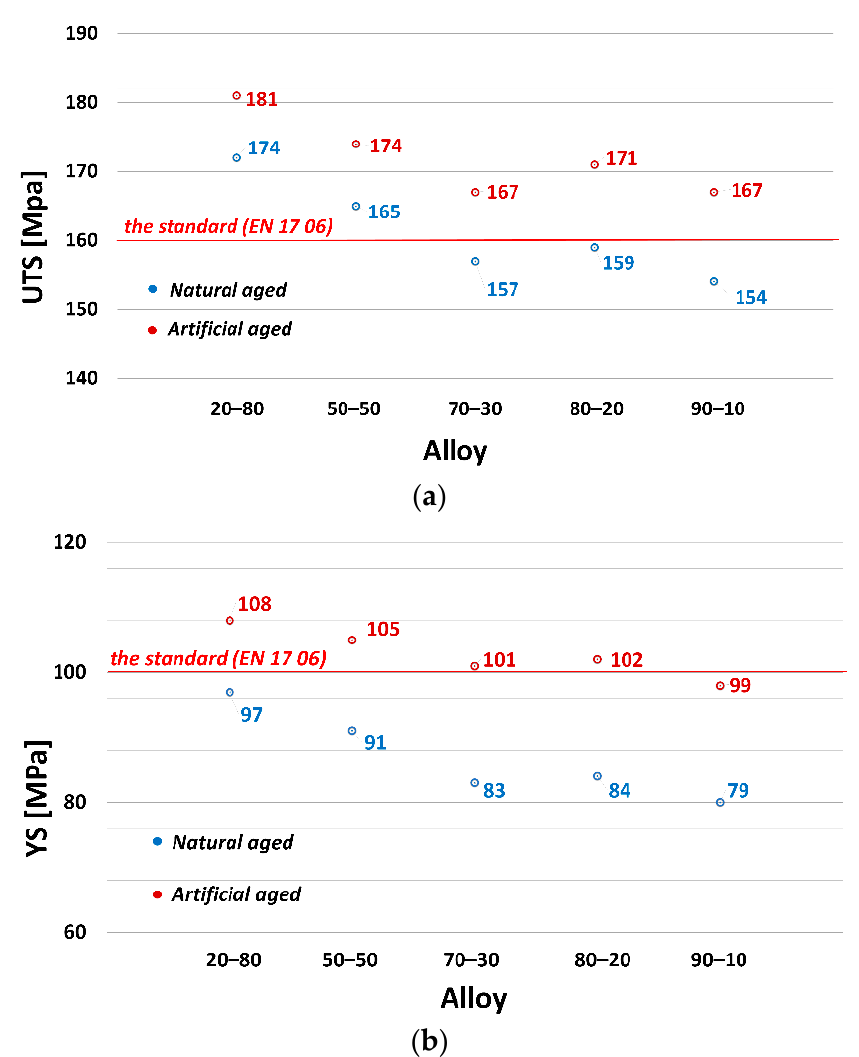
Figure 2. Relationship between: ( a ) Ultimate strength tensile; ( b ) Yield strength and experimental alloy and the state the alloy.